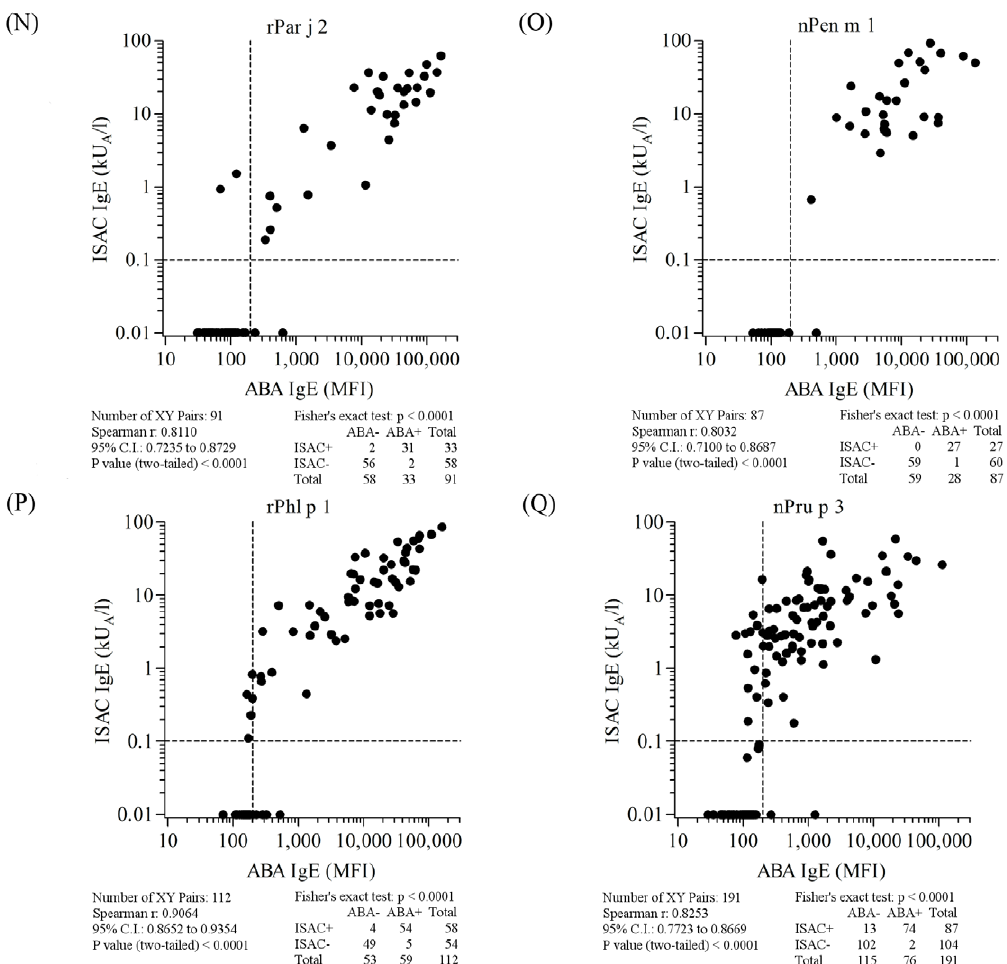
Figure 8. ABA versus ISAC correlation results on serum samples selected on the basis of the allergen specificities reported in each panel and listed in Table S1. Letter flags, namely N, O, P, Q, in figure 8 indicate them as parts of the results shown also in figures 5, 6, and 7. Consecutive letters are used on purpose to recall result type continuity across the four figures. Allergen nature, being either natural or recombinant, matched for both tests. Vertical dashed lines represent the arbitrary ABA negative cut off value. Horizontal dashed lines mark the value range where ISAC IgE determinations are not always reproducible (unpublished data). For graphical visualization needs on log scales, zero value for ABA was set at 10 MFI on the X axis, and at 0.01 kU/l for ISAC value on the Y axis. The Spearman r correlation coefficient was calculated and the Fisher’s exact test was used for statistical purposes. Statistical results are reported below each graph.